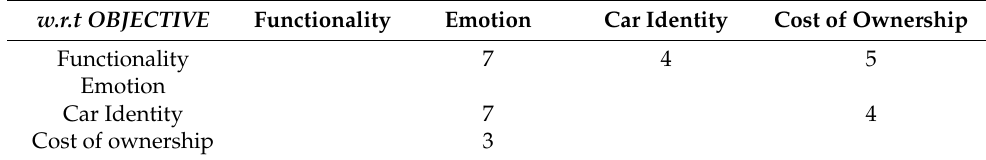
Table 3. Interviewee #1’s Pairwise comparison matrix of criteria with respect to ( w.r.t )